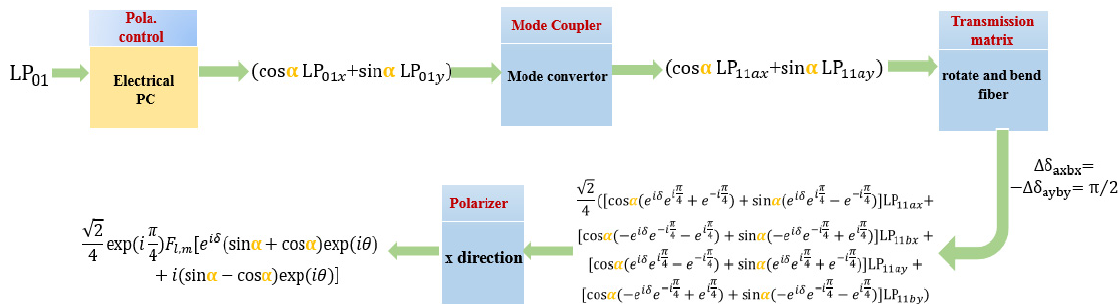
Figure 12. The flow chart of tunable OAM generation by adjusting the input polarization. Table 2. The fiber-based generation